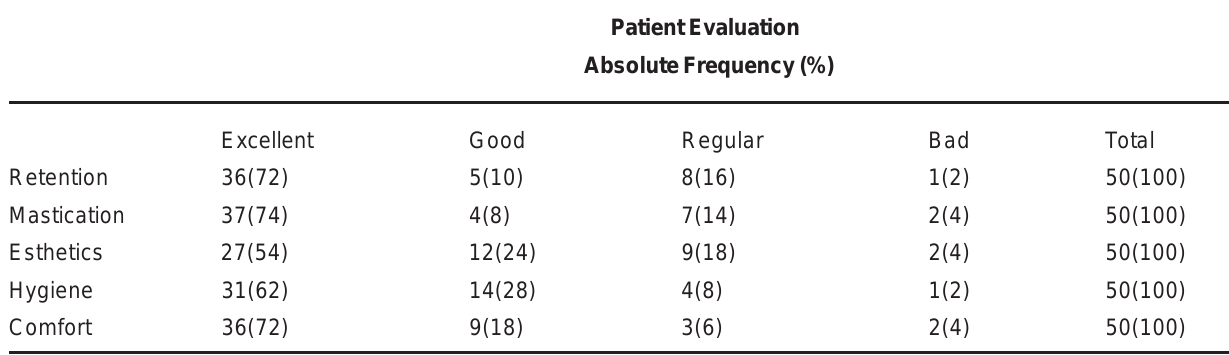
TABLE 2- Patient evaluation of retention, mastication, esthetics, hygiene and comfort